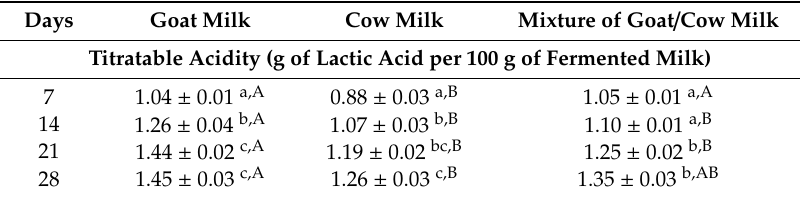
Table 2. E ff ect of storage on acidity (g of lactic acid per 100 g of fermented milk) of fermented milk produced using goat and cow milk and their mixture.